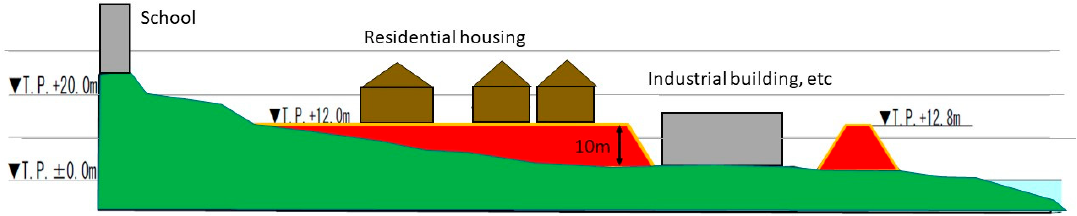
Figure 7. Diagrammatic representation of multi-layer safety interventions at Kirikiri.